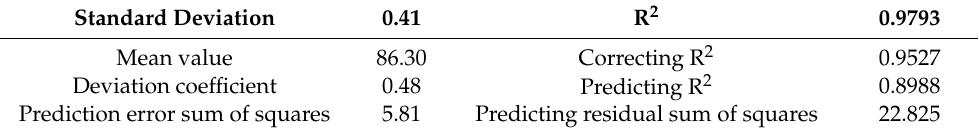
Table 3. Integrated evaluation of goodness of the recommended model in centrifugal separation tests.